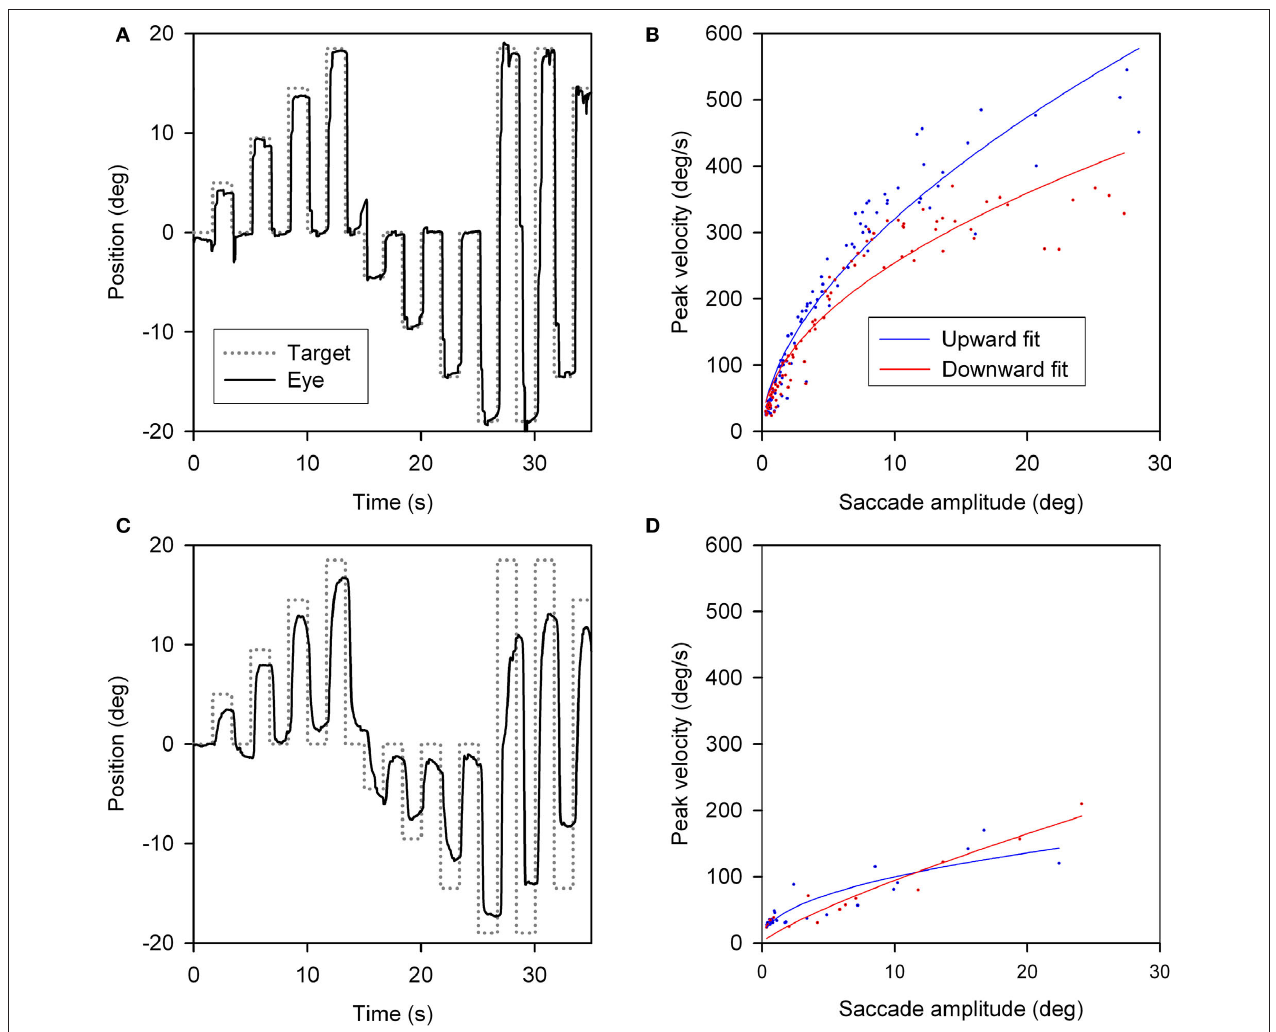
Figure 2 | Vertical saccades made by a normal subject and a patient with PSP. (A) Representative healthy elderly subject’s target-directed vertical saccades. (B) Peak velocity–amplitude relationship of these saccades, as modeled by the equation (peak velocity = K × amplitude L ). Both fit curves have